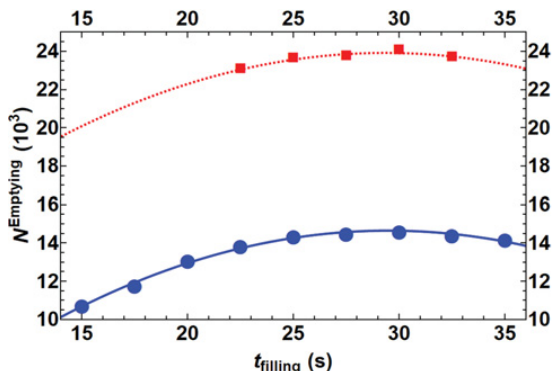
Figure 2. Plot showing the variation of total neutron counts after a fixed period of storage w.r.t. the filling time in seconds, along with a parabolic fit to the data-set. The red data set, with squares = 90s, for data points and dashed line fit, corresponds to t ∗ s whereas the blue data set, with dots for data points and solid line = fit, corresponds with t ∗ s